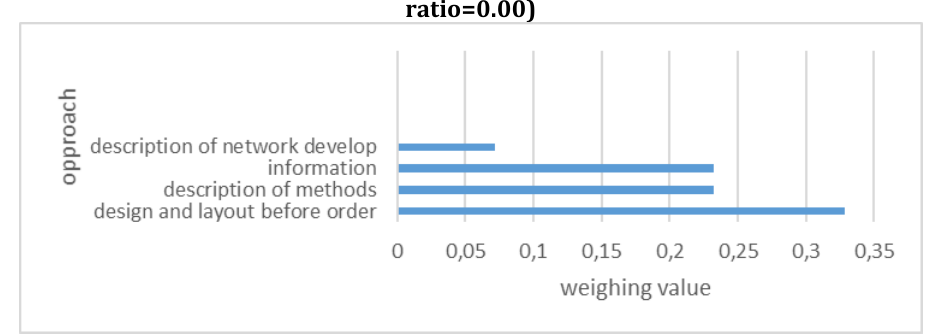
Figure 7: Result of services before sale sub criteria weighing value (Inconsistency ratio=0.00)